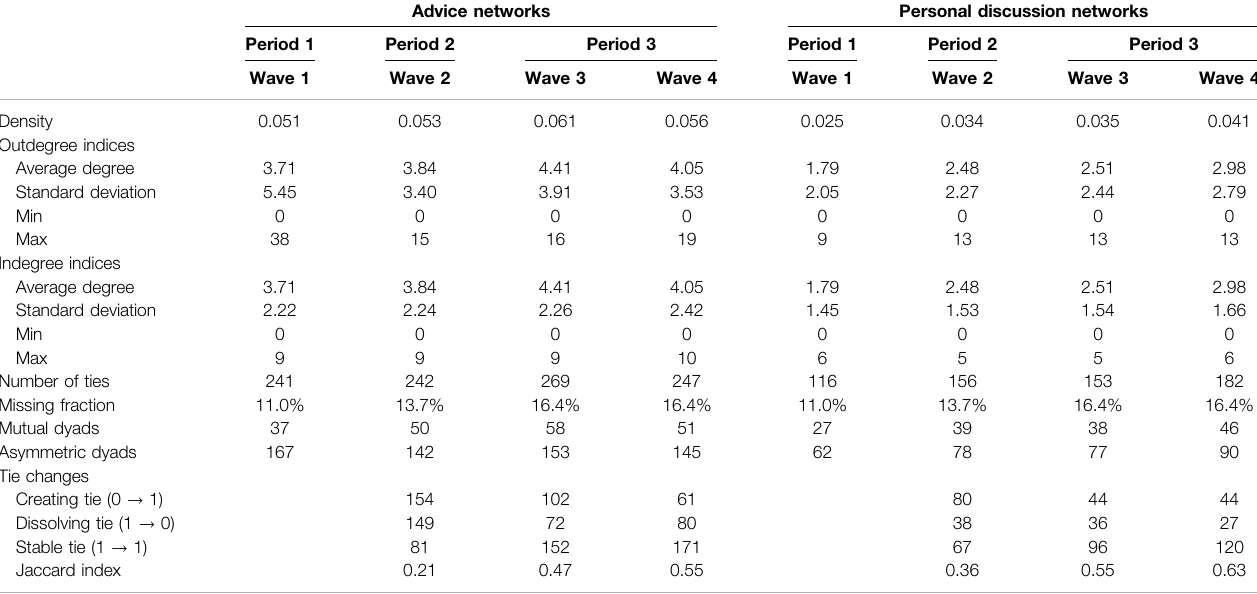
TABLE 1 | Descriptive statistics of advice and personal discussion